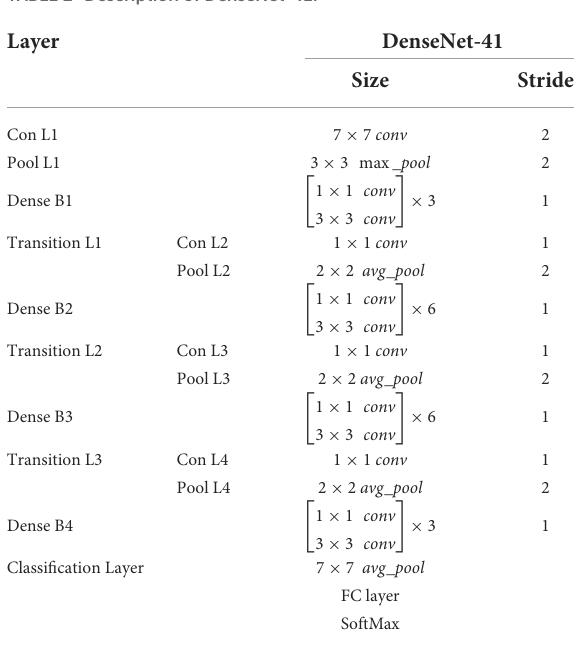
TABLE 2 Description of